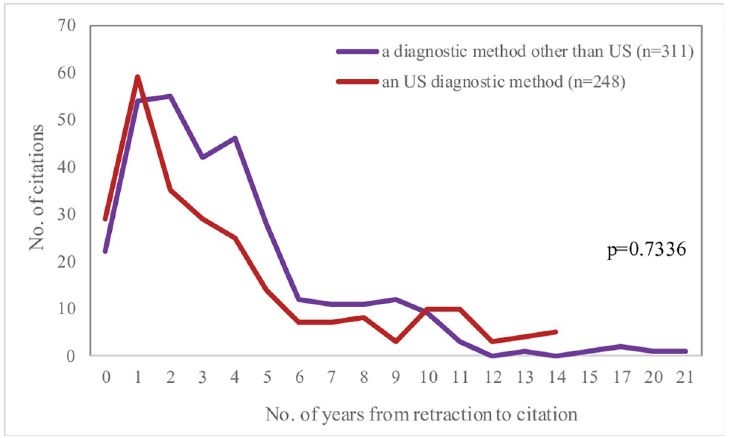
Fig 4. Flow of post retraction citations according to the number of years of the retracted paper. Zero corresponds to the number of citations in the same year when the paper was retracted.